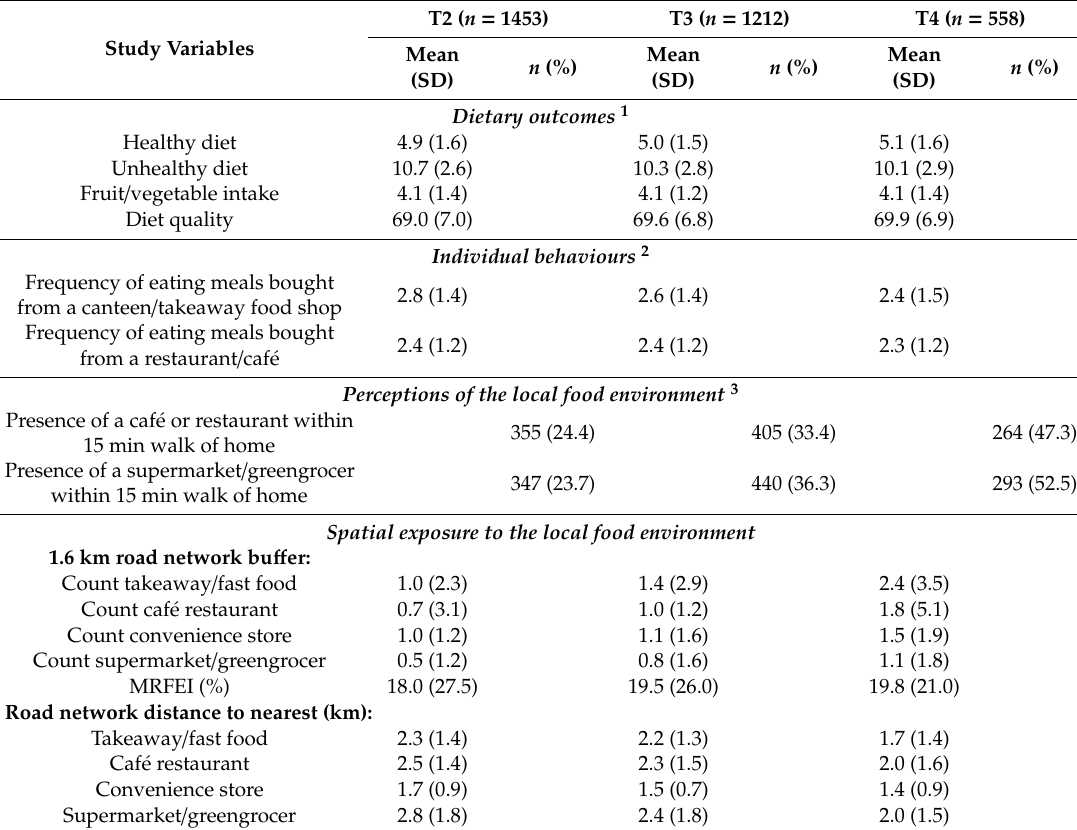
Table 2. Summary statistics of dietary outcomes and predictor